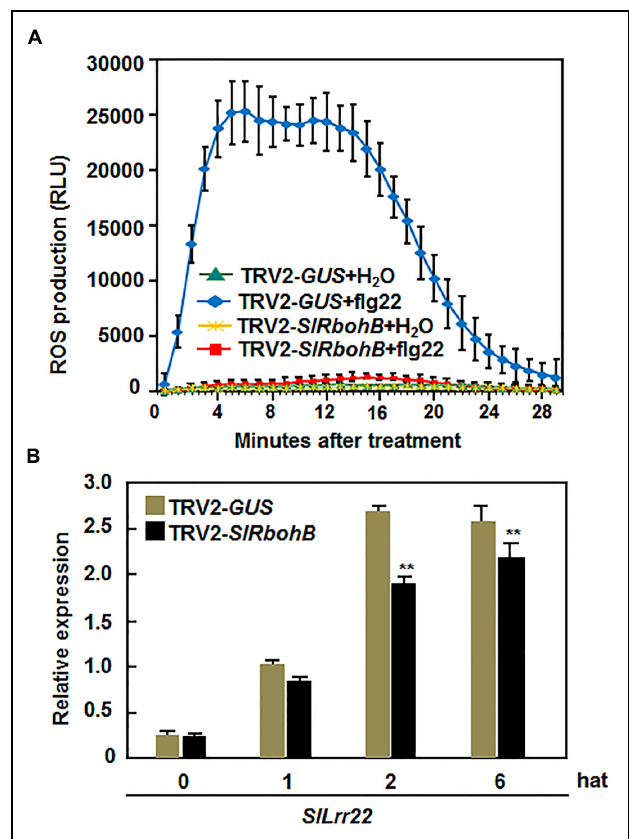
FIGURE 7 | Silencing of SlRbohB attenuated flg22-induced PTI. Two-week-old plants were infiltrated with agrobacteria harboring TRV2- SlRbohB or TRV2- GUS and the leaves were collected at 4 weeks after agroinfiltration. (A) Detection of flg22-induced reactive oxygen species (ROS) burst. ROS burst was monitored by a luminol-based assay immediately after addition of flg22 (400 nM) or solution. Repeated experiments showed similar results. (B) Expression of PTI marker gene SlLrr22 induced by flg22. Expression of SlLrr22 was analyzed by qRT-PCR and relative expression was shown as folds of the transcript levels at different time points vs. the value at 0 h after treatment (hat). Data presented are the means ± SD from three independent experiments and ∗∗ above the columns indicate significant difference at p < 0.05